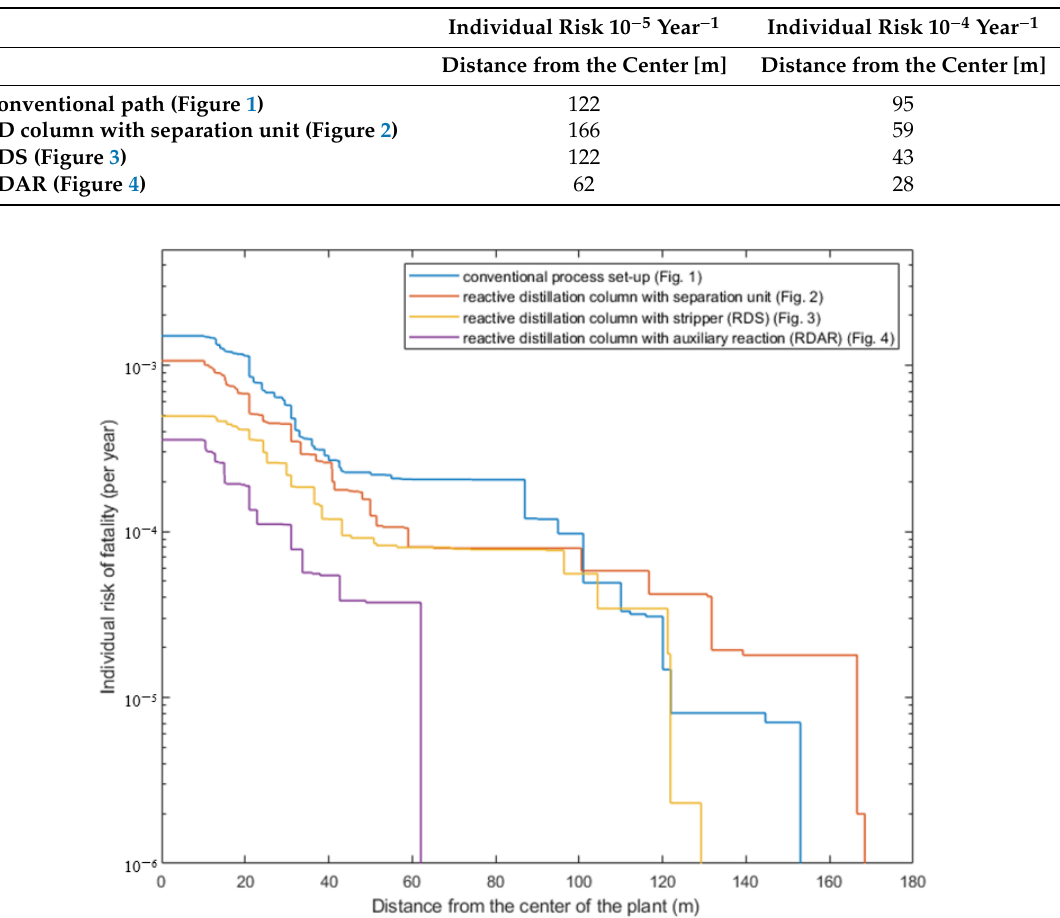
Table 13. Distance from the center for individual case studies up to which individual risk of fatality is lower than 10 − 5 resp. 10 − 4 year − 1 .